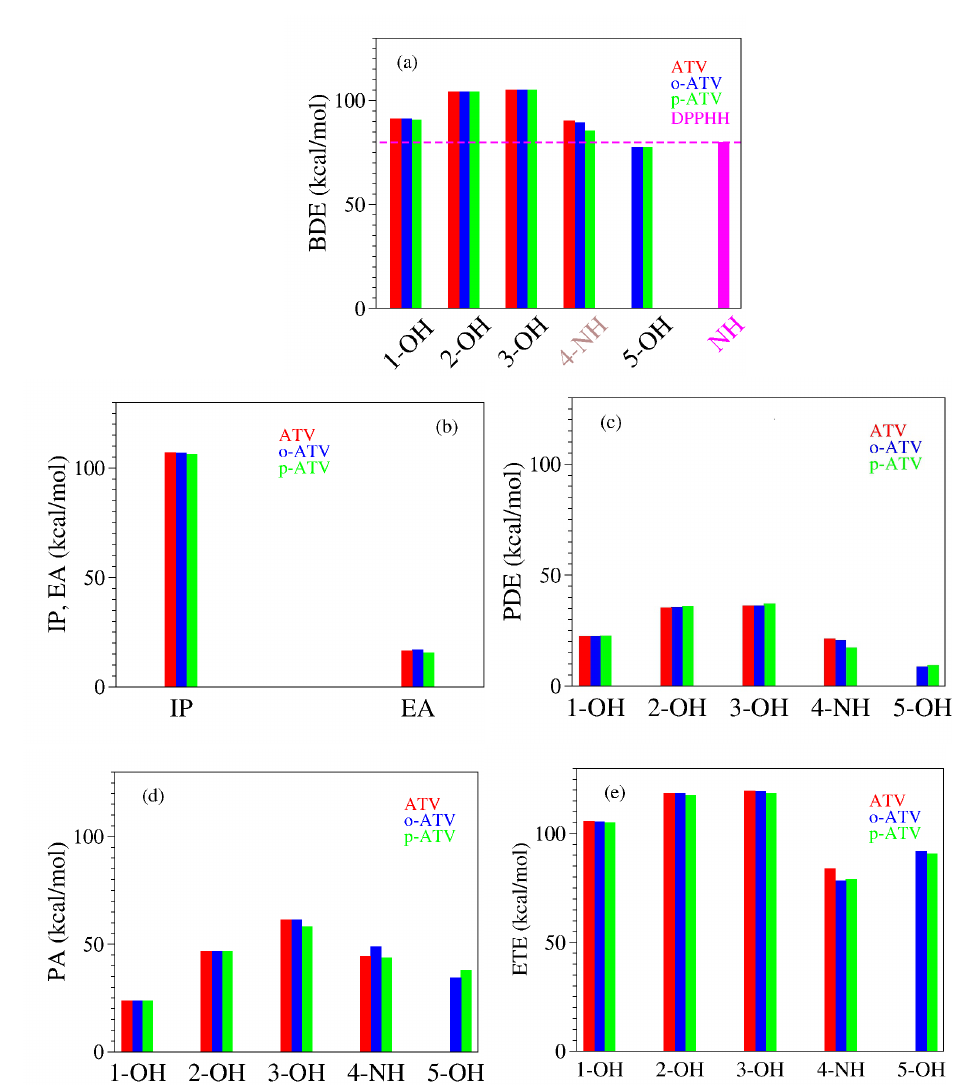
Figure 7. Enthalpies of reaction quantifying the antioxidant activity of atorvastatin (ATV) and its ortho- (o-ATV) and para- (p-ATV) hydroxy metabolites: ( a ) bond dissociation; ( b ) ionization and electron attachment; ( c ) proton detachment; ( d ) proton affinity; ( e ) electron transfer. The additional information for the DPPH • radical in panel ( a ) depicts why o-ATV and p-ATV can scavenge this radical while the parent ATV